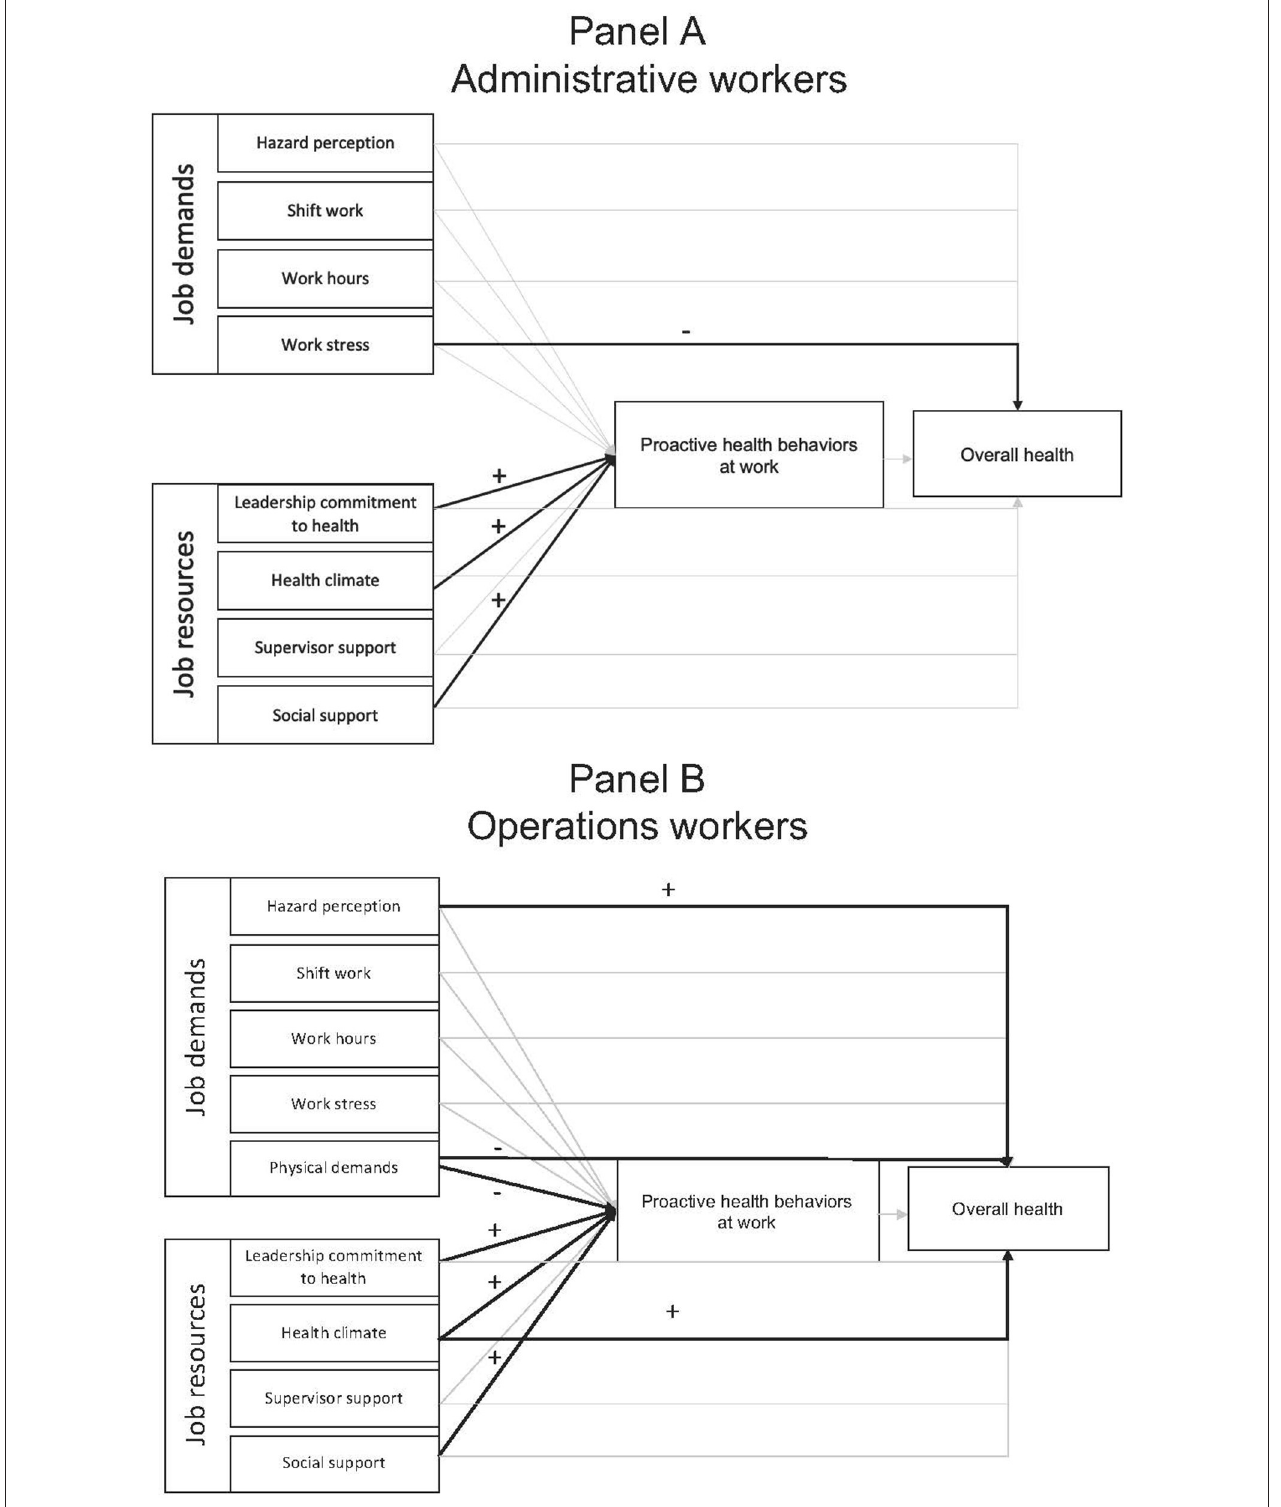
FIGURE 1 | Final job demands-resources model of workplace health amongst administrative and operations agricultural workers in Latin America. Controlling for the effects of age, gender, country in which they worked, and ethnicity. Significant paths depicted by bold, black arrows. Insignificant paths depicted by grey arrows. The direction of the effect is depicted with either a “ − ” for a negative relationship or a “ + ” for a positive relationship.